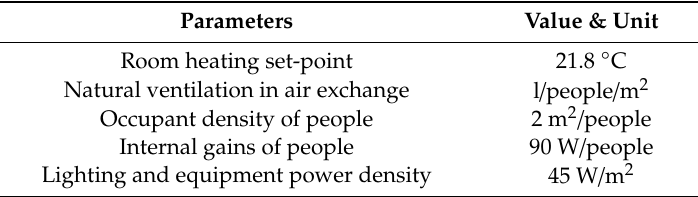
Table 1. Settings of other parameters in IES-VE model.